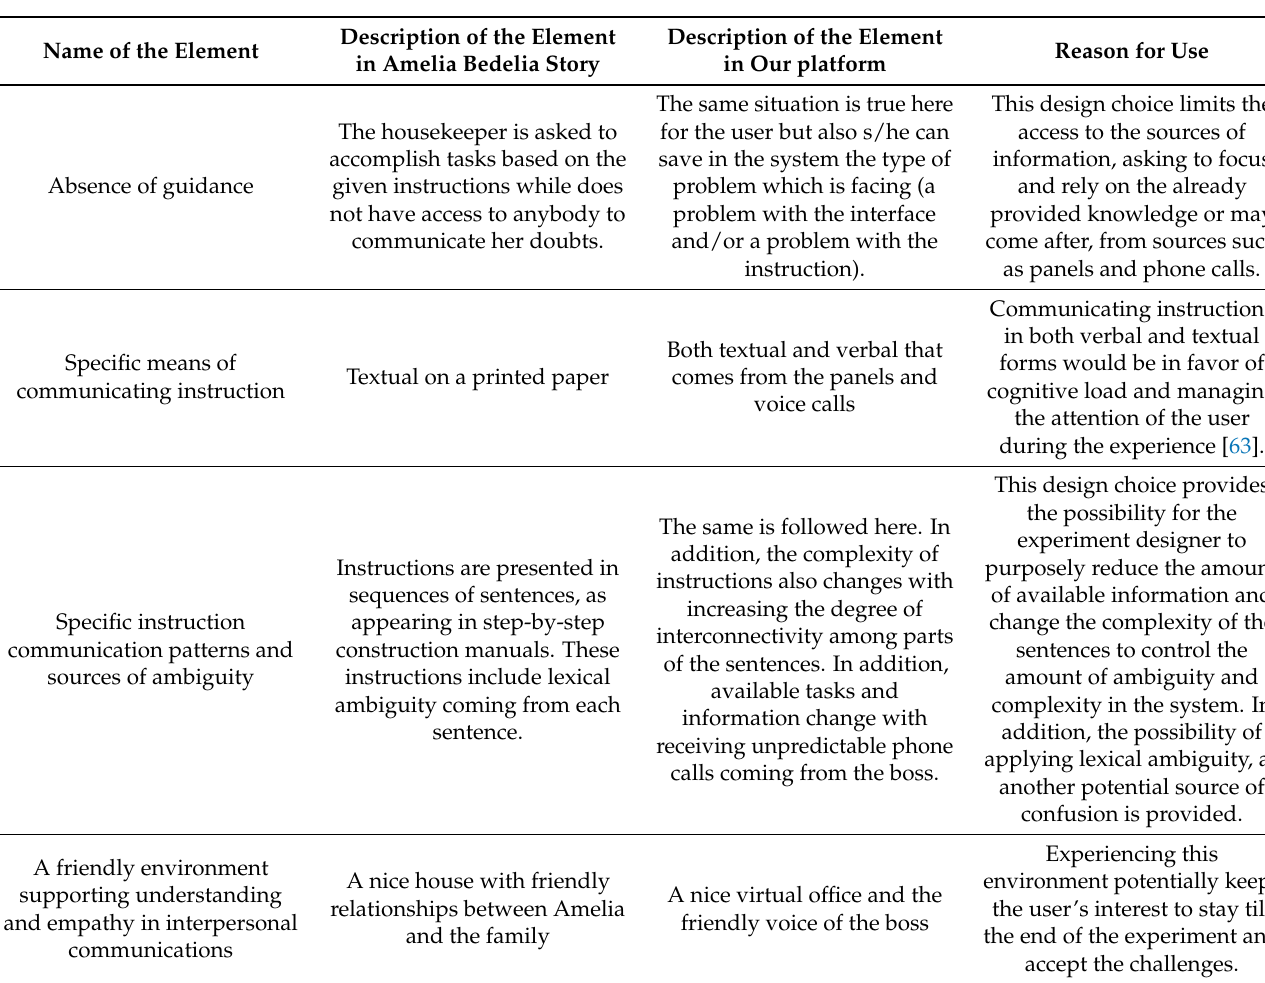
Table 3. A comparison of the elements in the proposed platform with those in the Amelia Bedelia